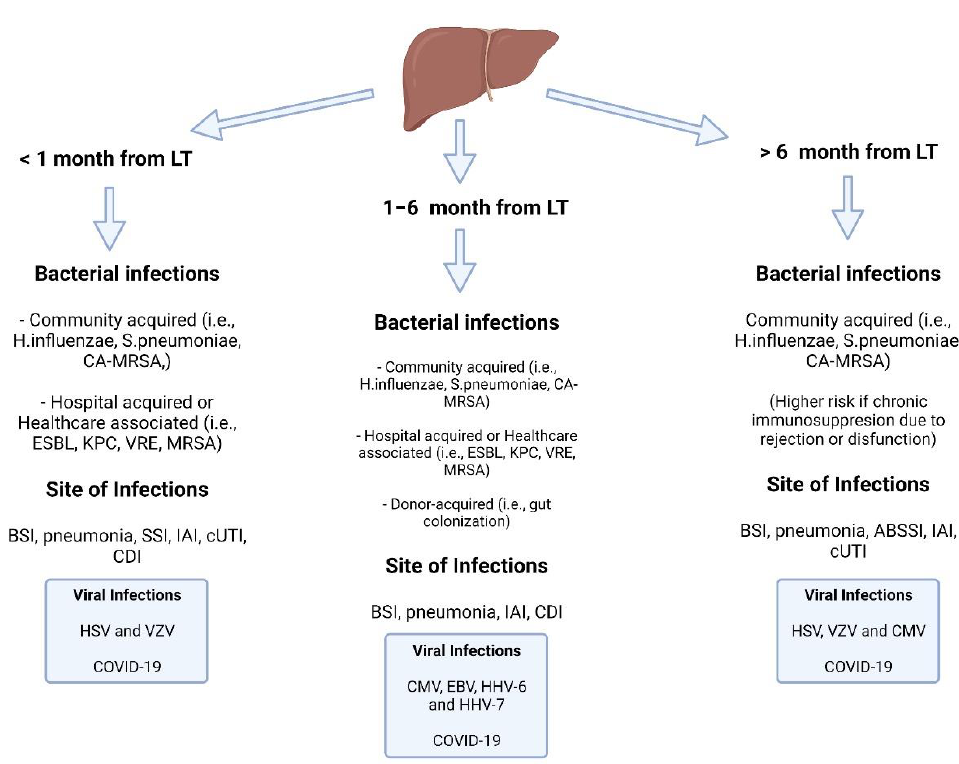
Figure 1. Timeline of bacterial and viral infections in the liver transplant recipient. Abbreviations: LT: liver transplant; CA-MRSA: community-acquired methicillin-resistant Staphylococcus aureus; ESBL: extended-spectrum beta-lactamase; KPC: Klebsiella pneumoniae carbapenemase; VRE: vancomycin-resistant Enterococcus; BSI: bloodstream infection; SSI: surgical site infection: IAI: intra-abdominal infection; cUTI: complicated urinary tract infection; CDI: C. difficile infection; HSV: herpes simplex virus: VZV: varicella zoster virus; EBV: Epstein-Barr virus; HHV: human herpes virus; ABSSI: acute bacterial skin and soft tissue